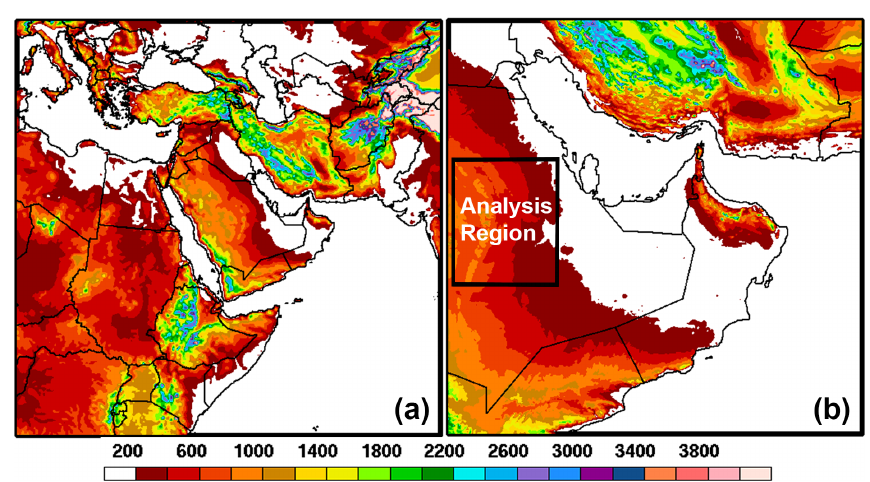
Figure 1. RAMS simulation domains with topography (shaded) for the domains with grid spacings of (a) 15km (Grid 1) and (b) 2km (Grid 2). The inset box denotes the dusty inland analysis region for the area-averaged time series and vertical profiles that follow. Table 1. Summary of RAMS model grid setup and simulation configuration.